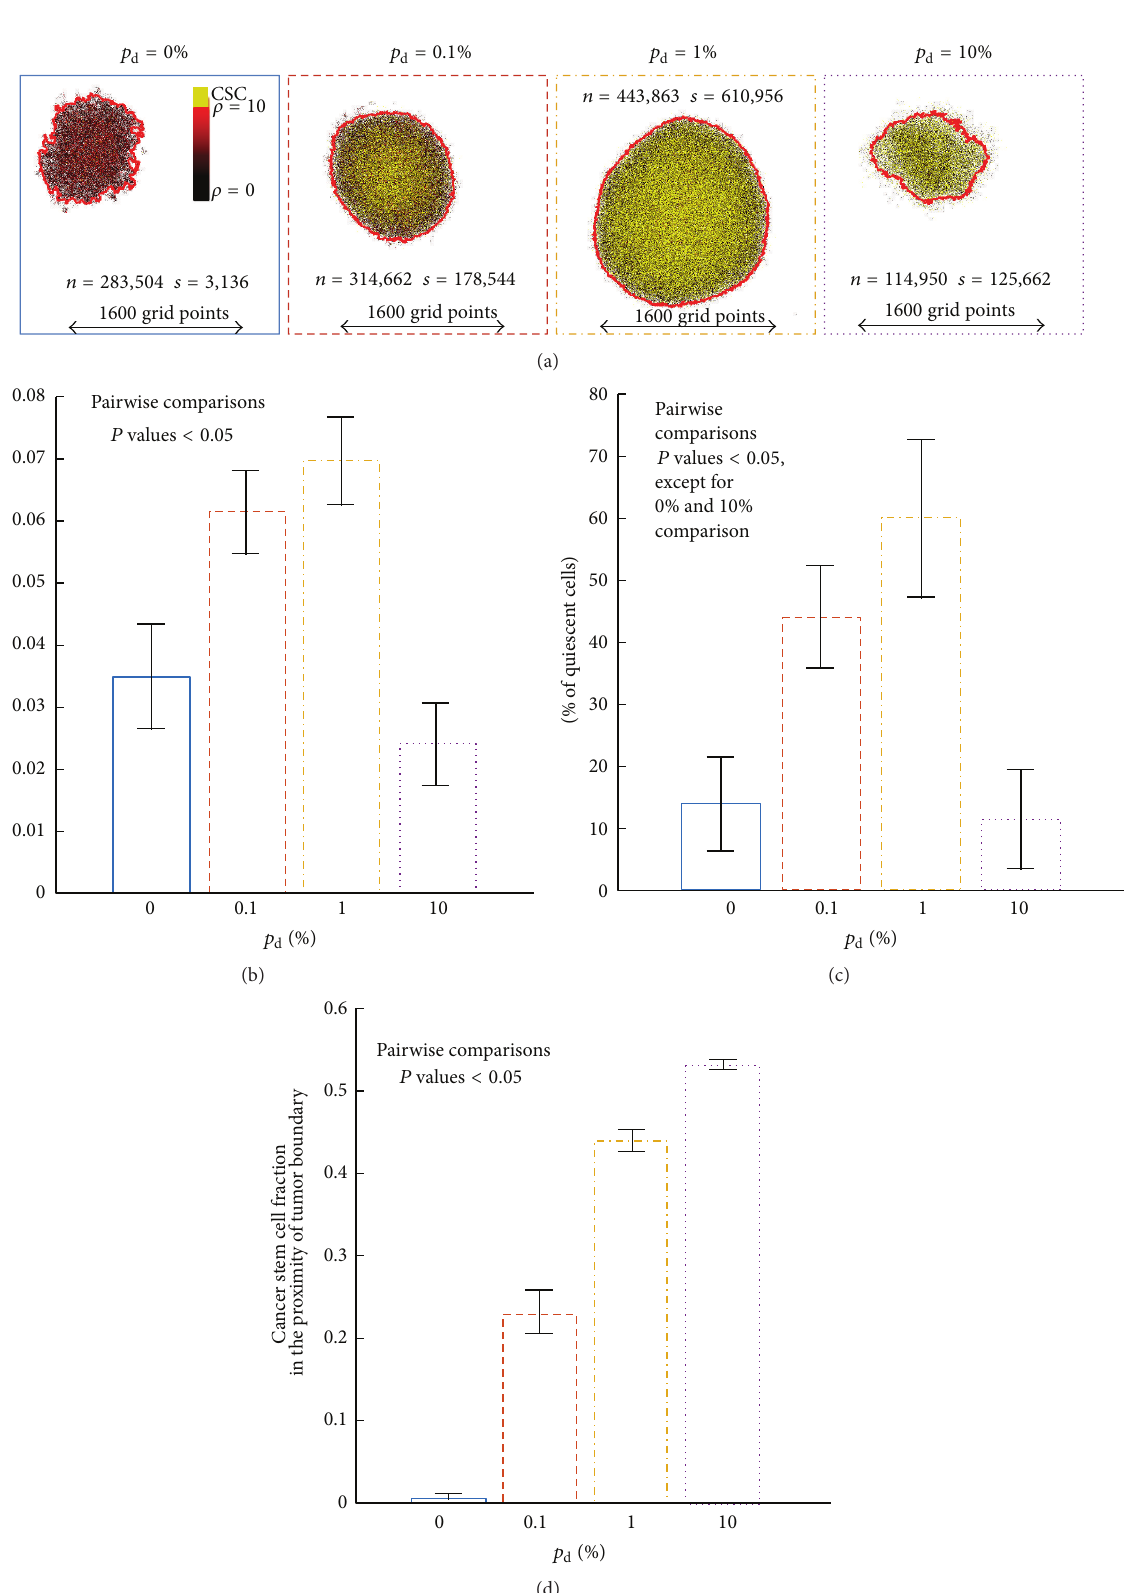
Figure 4: (a) Simulation snapshots of the biggest tumor at 𝑡 = 720 days for each considered plasticity event probability. 𝑠 : number of cancer stem cells; 𝑛 : number of cancer cells. Comparison of circularity (b), percent of quiescent cells (c), and cancer stem cells fraction in 200 𝜇 m proximity of tumor boundary (d) for different probabilities of plasticity event. Shown are means ± SD from 100 simulation runs (only successfully grown tumors are